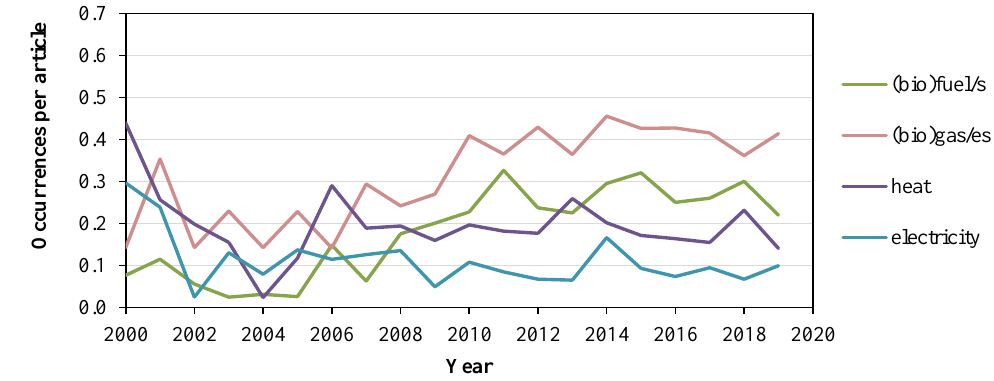
Figure 9. Trend chart of terms related to produced energy.